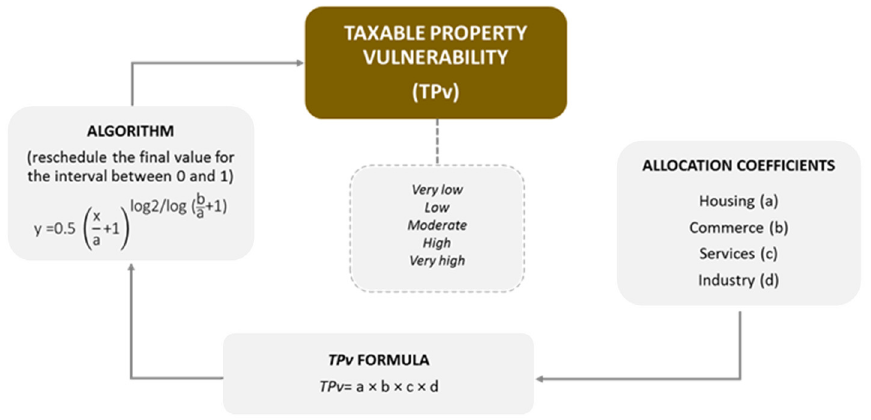
Figure 8. Graphical process of taxable property vulnerability calculation.